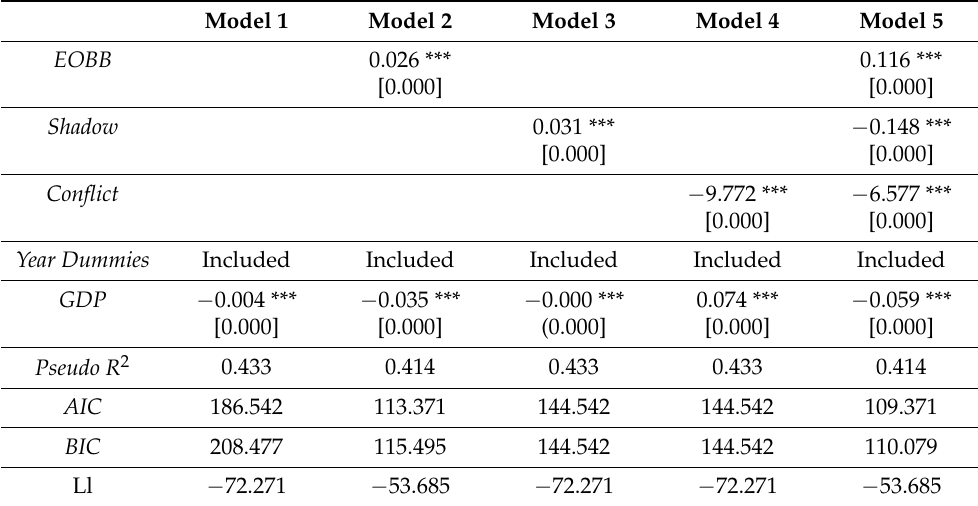
Table 4. Number of deals involving Ukrainian